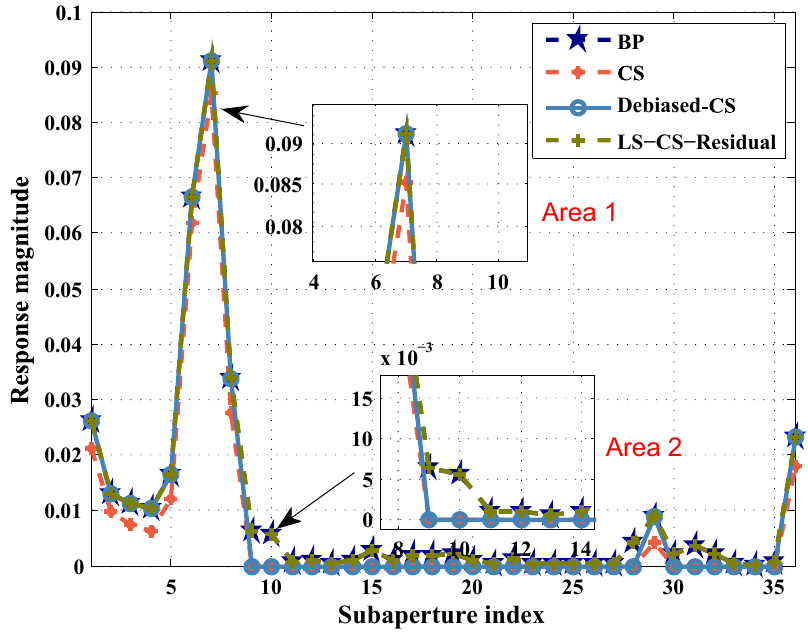
Figure 3. Reconstructed aspect dependent scattering of pixel P via the three